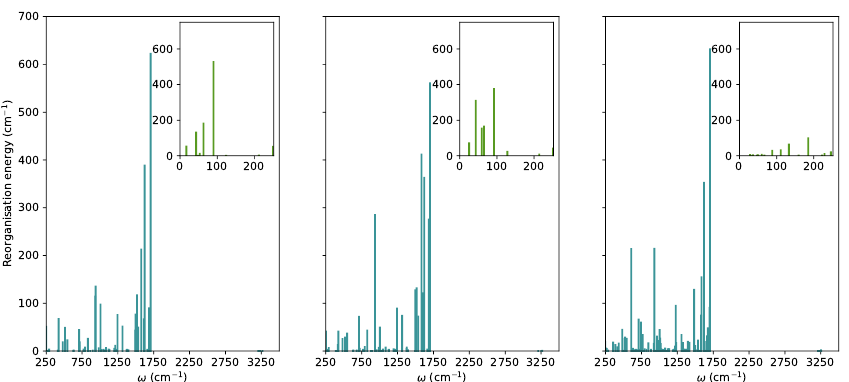
Figure 2. The reorganization energies for the relaxation from the S 1 state in TPF computed based on the TD- ω B97XD/6-31G(d) normal modes and energies in the vacuum, solution, and crystal (from left to right).